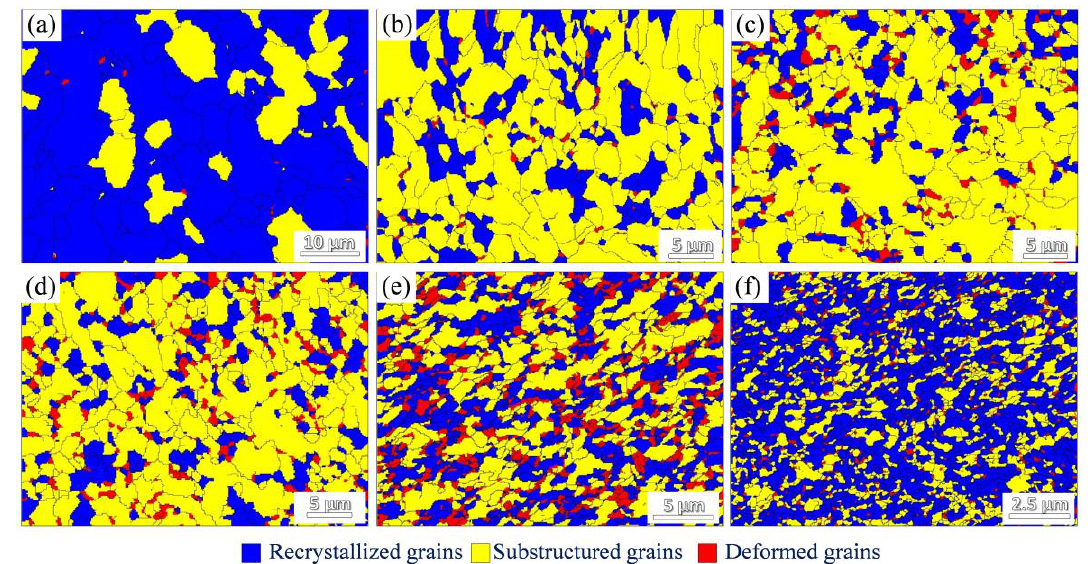
Figure 8. The distribution of recrystallized, substructured, and deformed grains of the as-drawn composites with different drawing reductions: ( a ) 36.0%, ( b ) 67.3%, ( c ) 73.6%, ( d ) 81.6%, ( e ) 91.3%, and ( f ) 99.7%.